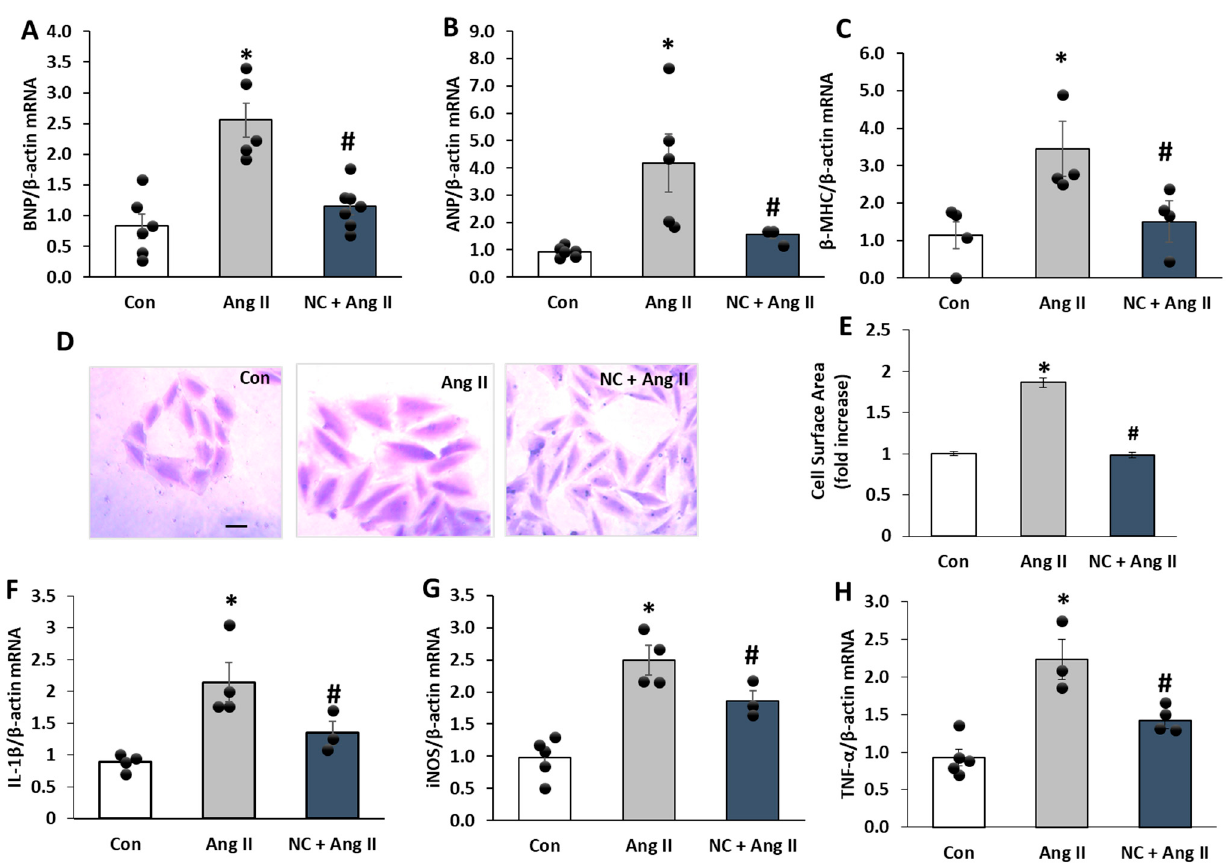
Figure 5. NC reduced the mRNA expression of hypertrophy and proinflammatory genes induced by Ang II in H9c2 cells. Treatment with NC (10 µg/mL) prior to Ang II (1 µM) reduced BNP ( A ), ANP ( B ), and β -MHC ( C ) mRNA expressions compared to Ang II alone. ( D ) Images representing morphological changes in H9c2 cells stained with crystal violet; scale bar = 5 µm. ( E ) Cell surface area was analyzed and is presented as mean (n = 150 cells/group). Treatment with NC prior to Ang II reduced IL-1 β ( F ), iNOS ( G ), and TNF α ( H ) mRNA expressions compared to Ang II alone. * p < 0.05 vs. Con and # p < 0.05 vs. Ang II. Values are means ± SEM (n ≥ 4–6 independent experiments for each treatment group).